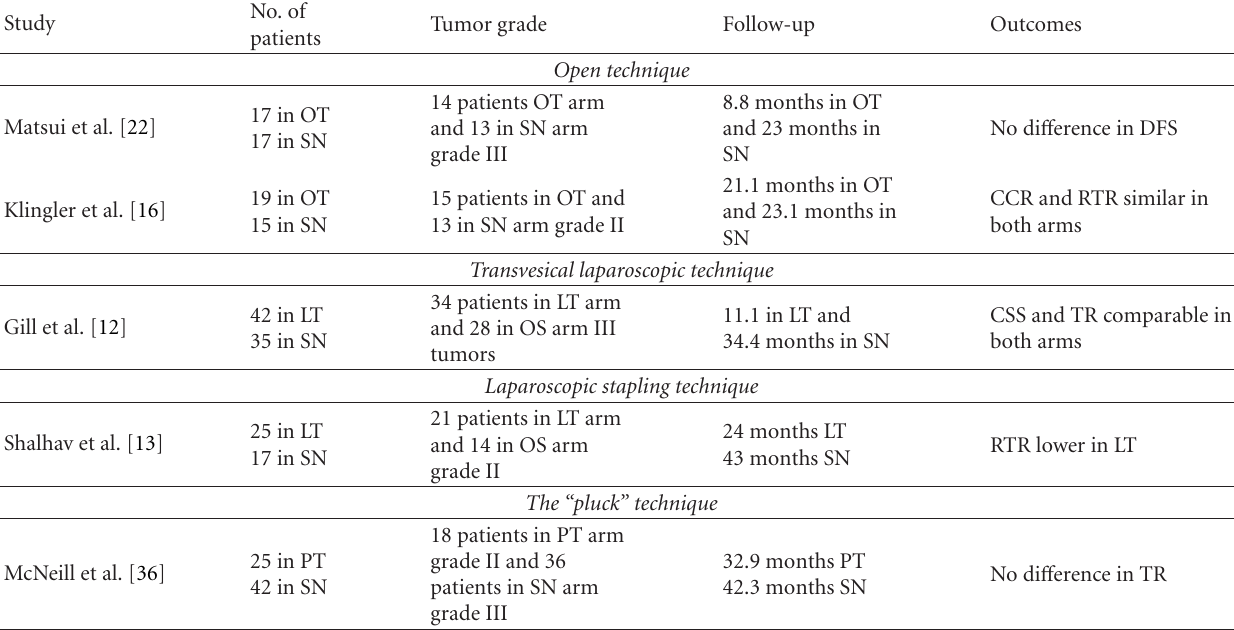
Table 4: Studies that compare techniques for the management of distal ureter end bladder cu ff with other methods of treatment. No. of Study Tumor grade Follow-up patients